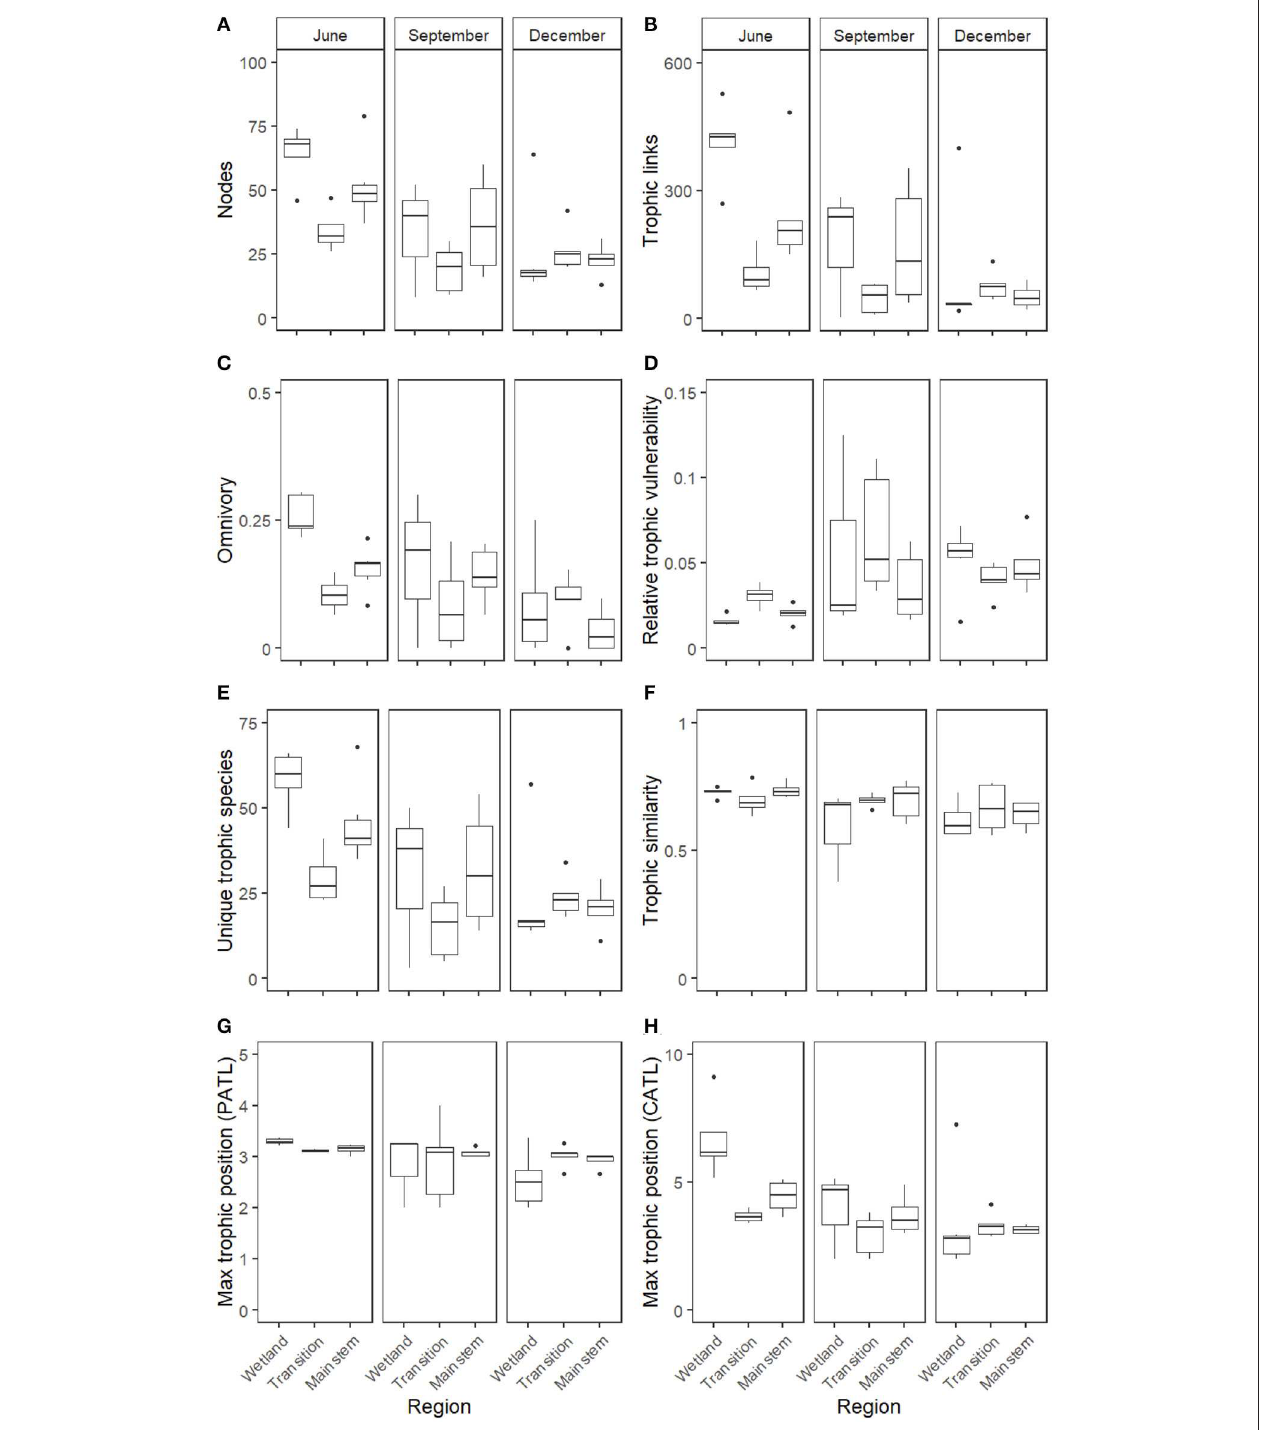
FIGURE 3 | Boxplots of the eight measured heuristic food web properties, expressed across the three regions of the GLM complex (Wetland, Transition, and Mainstem) and across the three seasons of the study (June, September, and December). Food web metrics included the following whole-network properties: (A) the number of nodes, (B) the number of trophic linkages among nodes, (C) the proportion of omnivory, (D) relative trophic vulnerability, or the average vulnerability across all nodes, standardized by the number of trophic linkages, (E) the number of unique trophic species, (F) the trophic similarity measured across all nodes, (G) the maximum prey-averaged trophic position, and (H) the maximum chain-averaged trophic position.